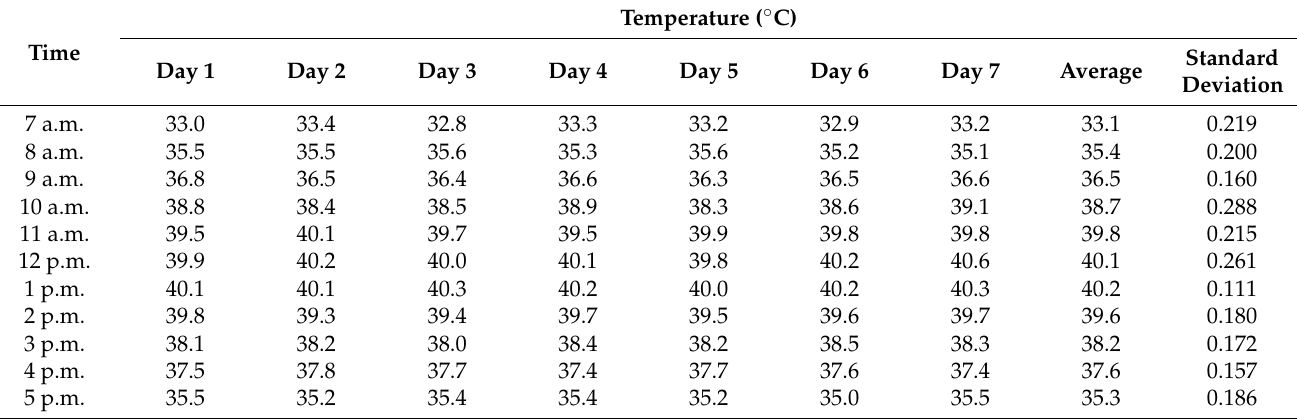
Table 1. Temperature in the greenhouse without the misting system.